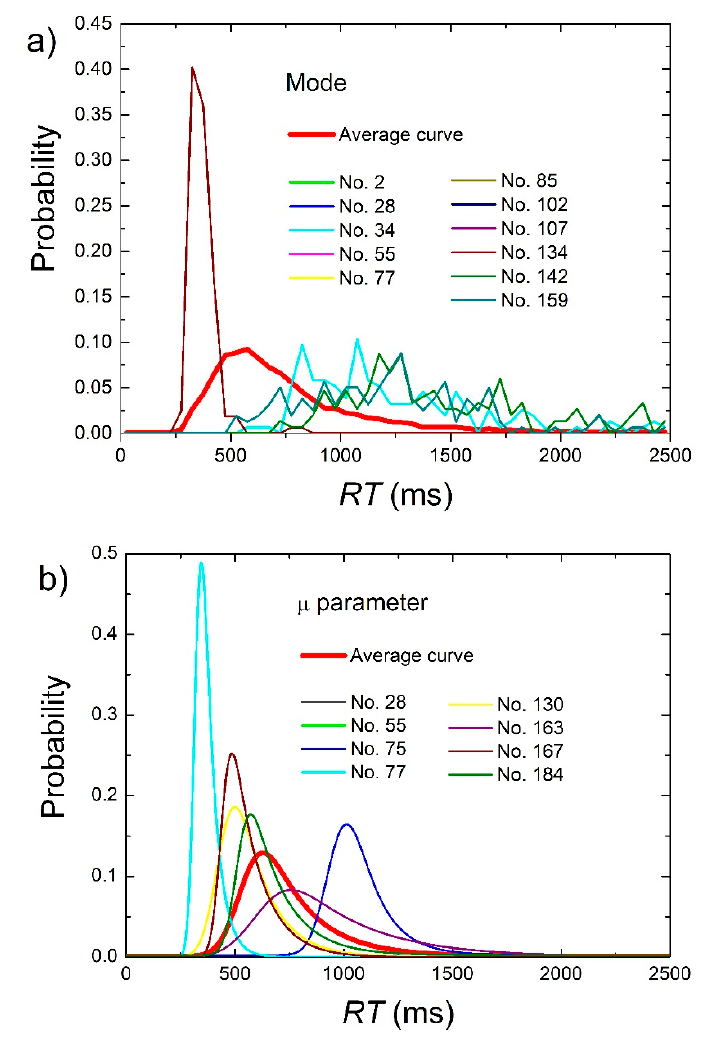
Figure 7. Probability distributions of the candidates resulting from the probability distribution of the mode in panel ( a ) and of the candidates resulting from the probability distribution of the parameter µ in panel ( b ). The average curve has also been included.